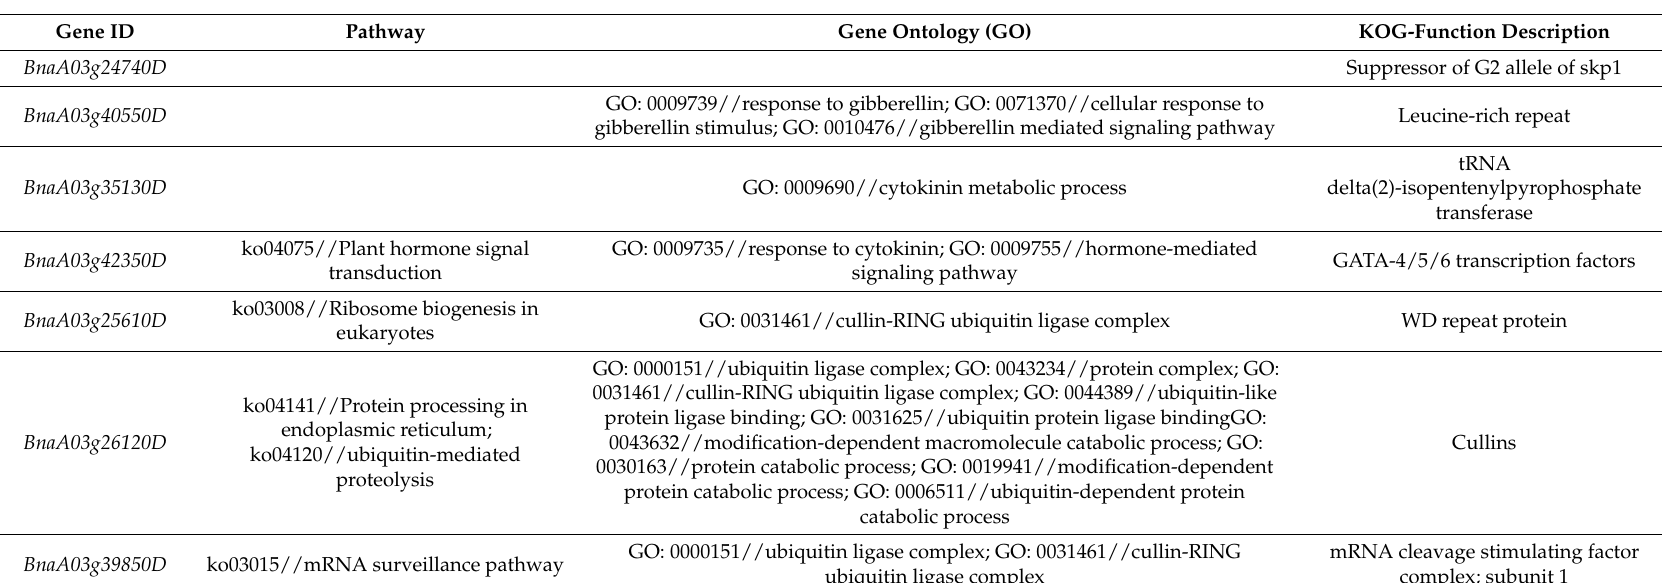
Table 7. Seven of the candidate genes screened out by annotation information. KOG: Clusters of Orthologous